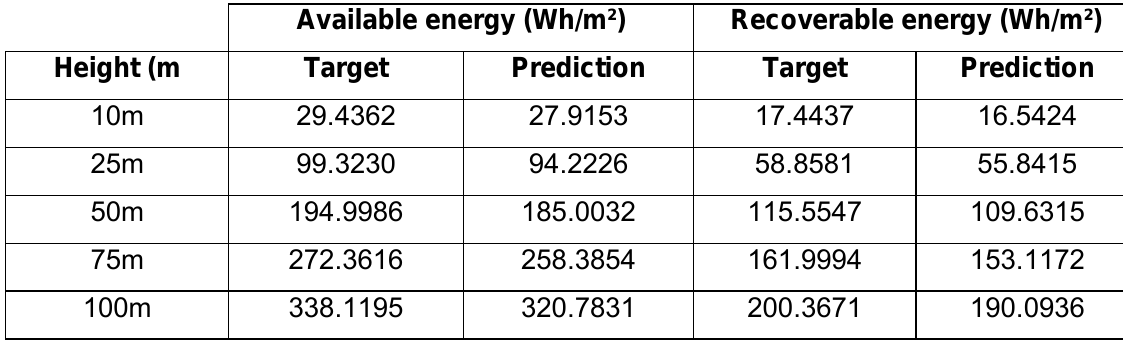
Table 4. Predicted energies at different